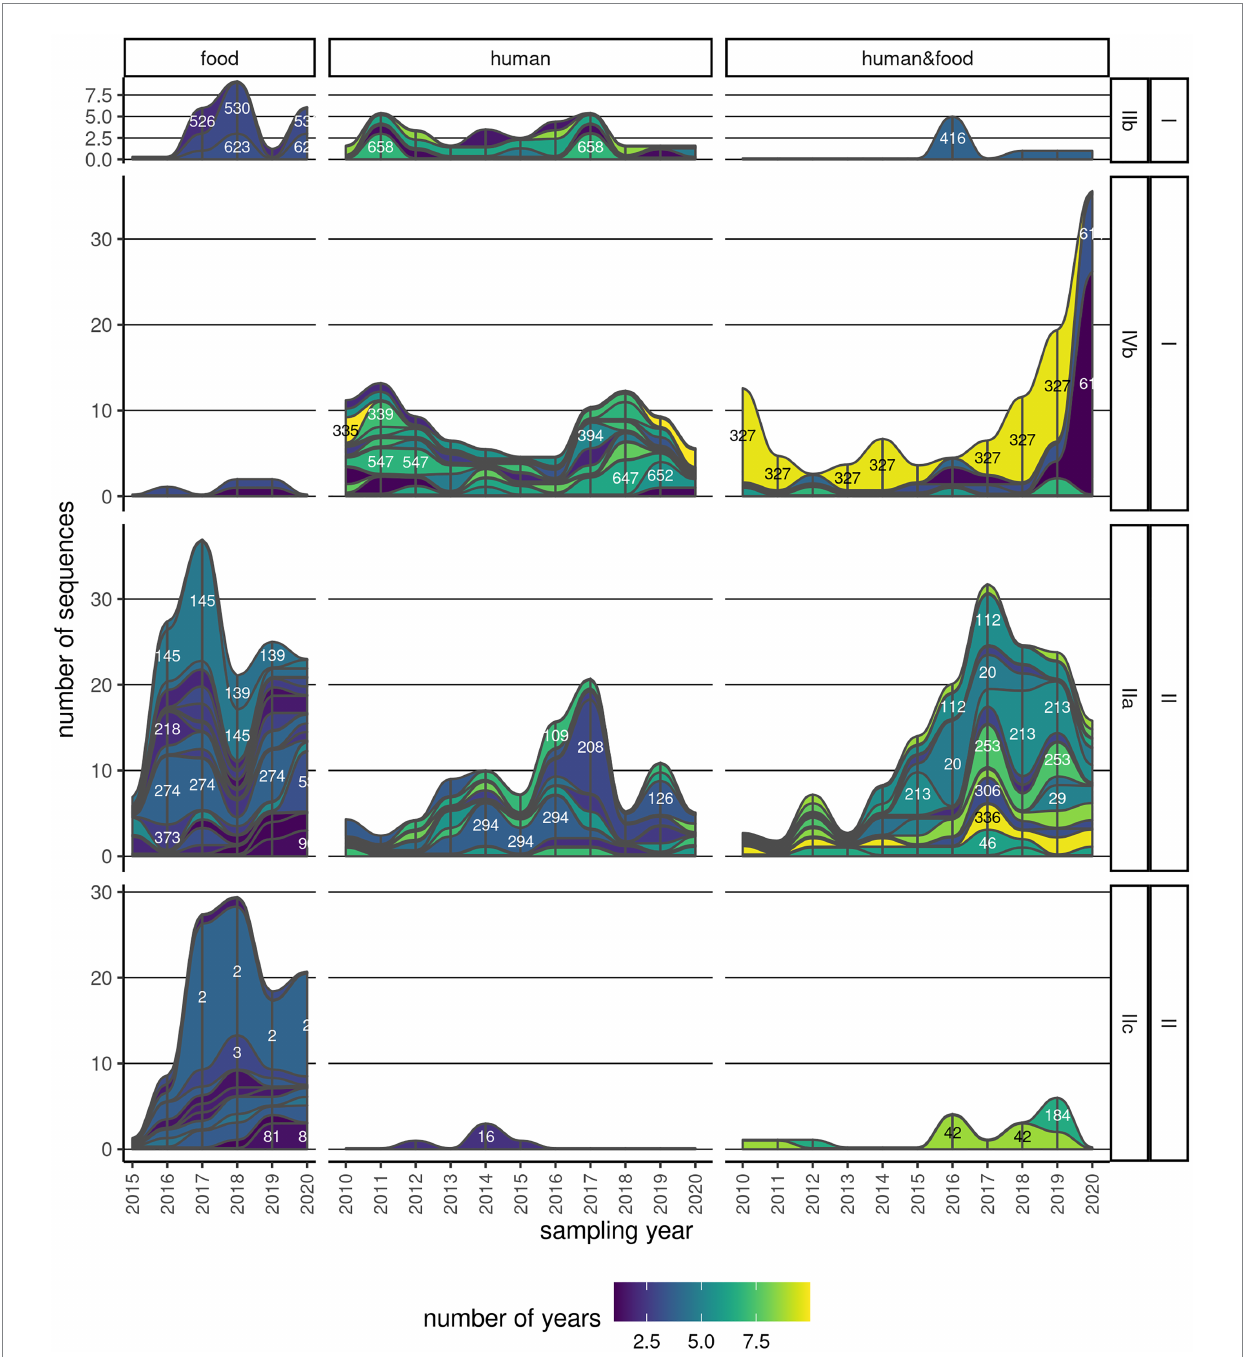
FIGURE 4 Persistence of clusters across multiple years. One continuous strip represents one cluster, with the corresponding name/number indicated on the strip, and its membership to serogroup and lineage indicated on the labels on the right. The color is indicative of the time span that the cluster has been found in either human, food, or both sample types. The thickness of the strip is proportional to the number of sequences in the cluster in a particular